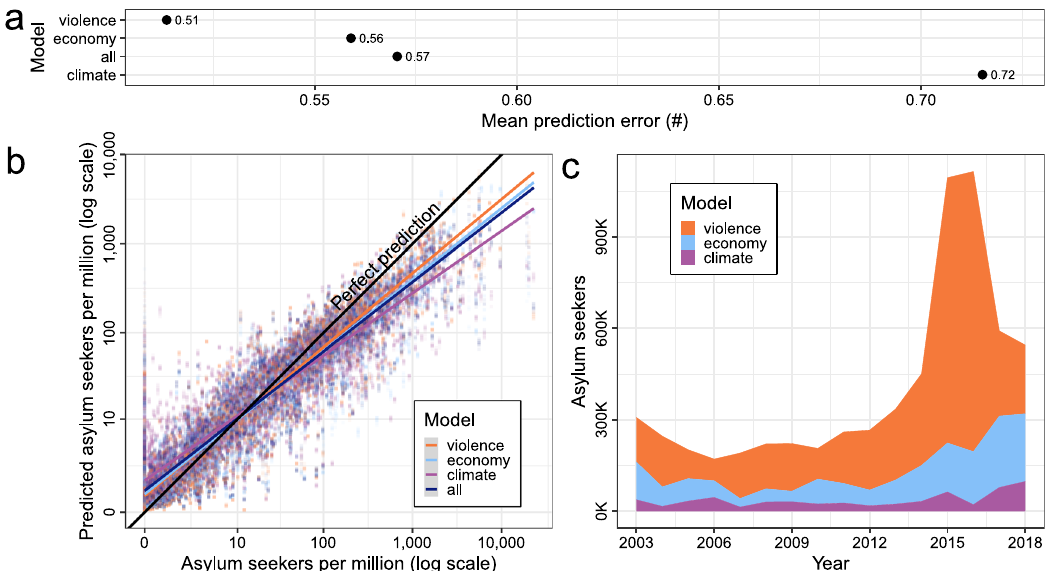
Fig. 3 Out-of-sample prediction performance by model. a Mean out-of-sample prediction error of random forest (RF) component models. b Predicted vs. observed numbers of asylum applications with imposed model average linear effects for the violence component model (orange), economy model (light blue), climate model (purple), and the complete model (dark blue). c Share of annual global volume of asylum seekers best predicted by each RF component model. The results in a – c are generated from leave-future-out cross-validation, trained on alternative 4-year subsets of empirical data for the period 1999 – 2017, and tested against observed outcomes for the subsequent year 2003 – 2018. N = 3413 country-year observations, examined over 160